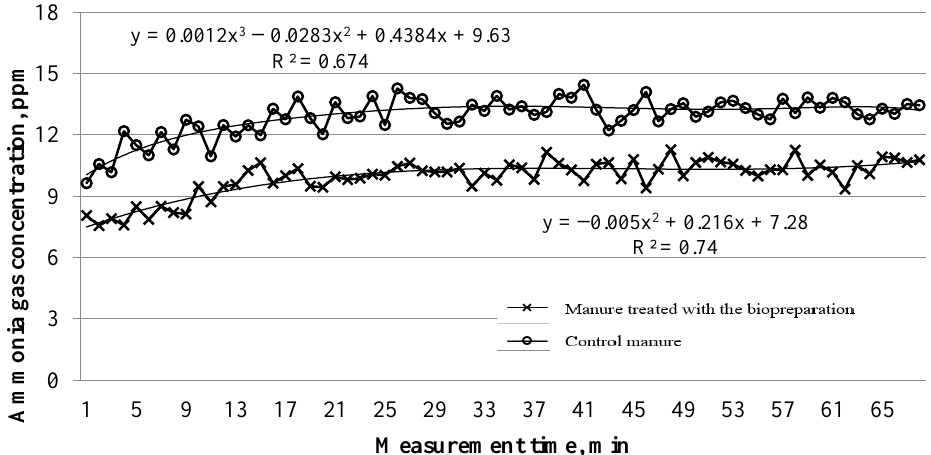
Figure 3. Change in ammonia concentration in the wind tunnel with the addition of the manure treated with the biopreparation and the control manure without additives (10 days after the addition of the biopreparation without mixing the manure).